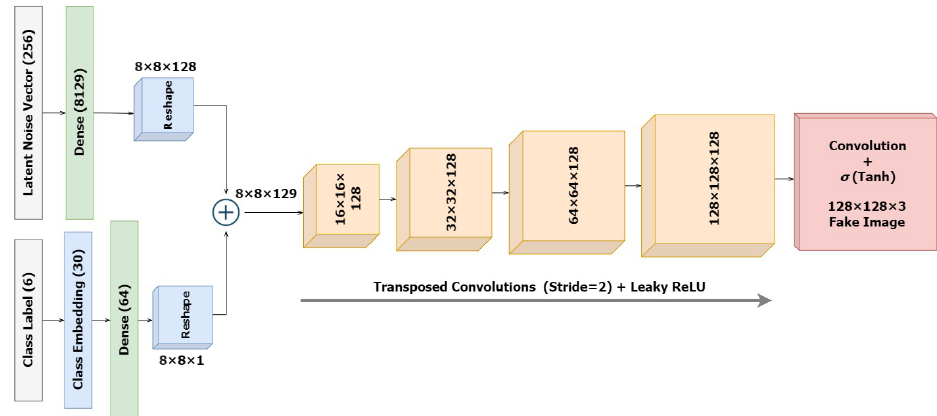
Figure 5. Architecture of the Conditioned Generator.